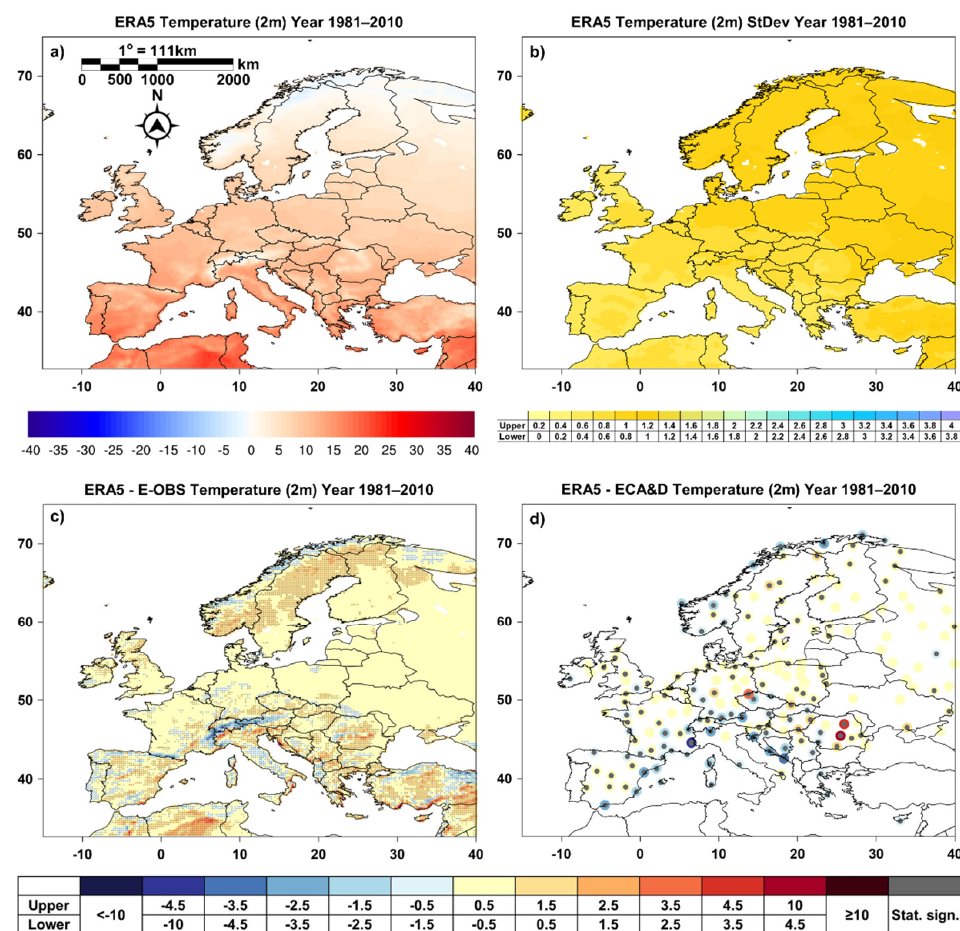
Figure 3. ( a ) Mean temperature (°C) and ( b ) standard deviation for ERA5, and the differences between ( c ) ERA5 and E-OBS, and ( d ) ERA5 and ECA&D stations.